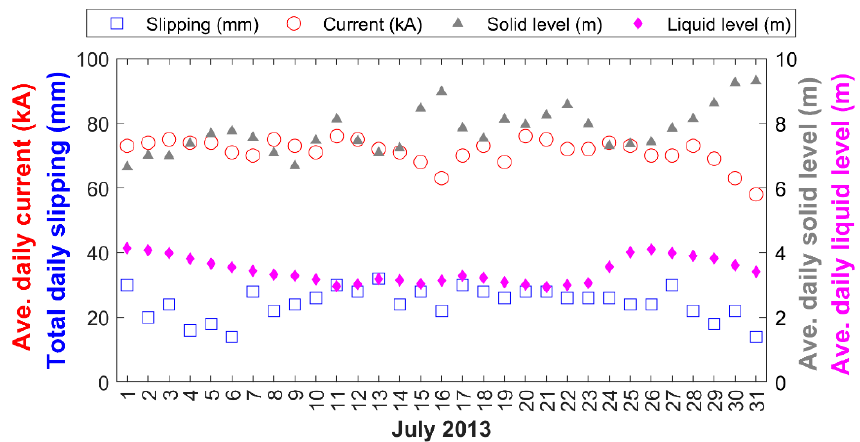
Figure 4. Total daily slipping taken on the case study electrode, daily average current passing through it, as well as daily average solid and liquid paste levels in the month prior to the furnace shutdown.